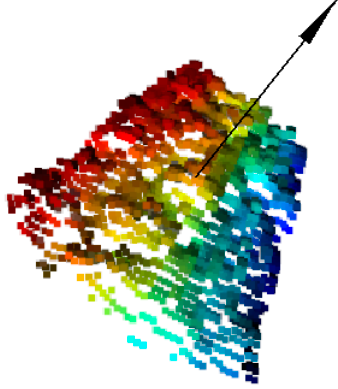
Figure 14. Normal line estimation results of tea box surface.